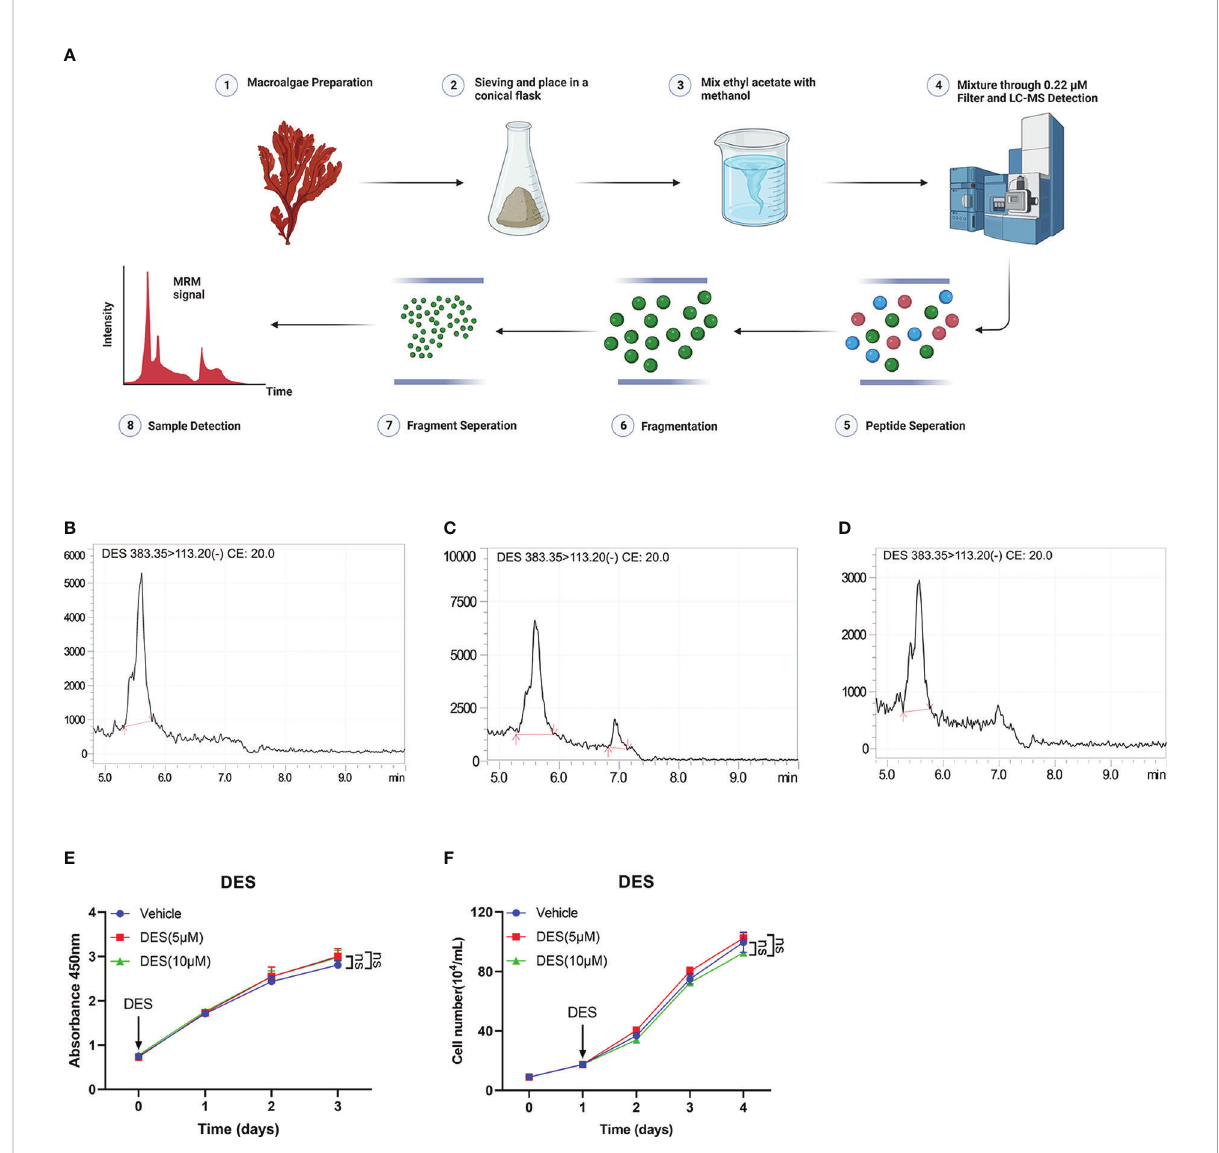
FIGURE 1 DES does not affect cell growth and survival in IPI-2I cells. (A) Overview of sample preparation and detection work fl ow. (B) DES was determined by LC-MS and quanti fi ed with multiple reaction monitoring (MRM) mode. MRM chromatograms of DES standards in 250 m g/mL (C) and 25 m g/ mL (D) determined by LC-MS. (E) DES (5 m M/10 m M) treatment in IPI-2I cells for 0, 24, 48, and 72 h by CCK-8 detection. (F) Cell counting analysis at the indicated time (0, 24, 48, and 72 h) with DES (5 m M/10 m M) treatments in IPI-2I. The data are shown as the means ± SD, n ≥ 3 per group. The experiments were repeated 3 times. ns, represents differences not signi fi cant, using Student ’ s t -test